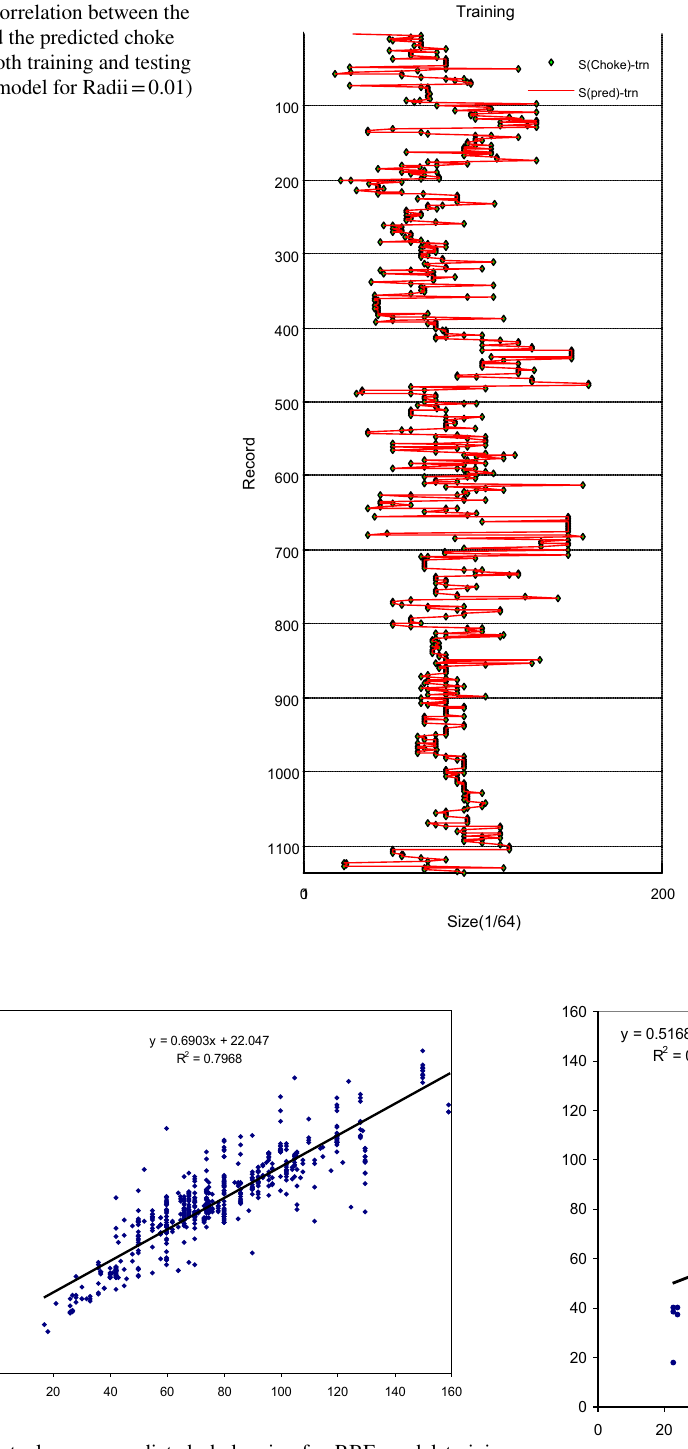
Fig. 13 Correlation between the actual and the predicted choke size for both training and testing data (FL model for Radii = 0.01)